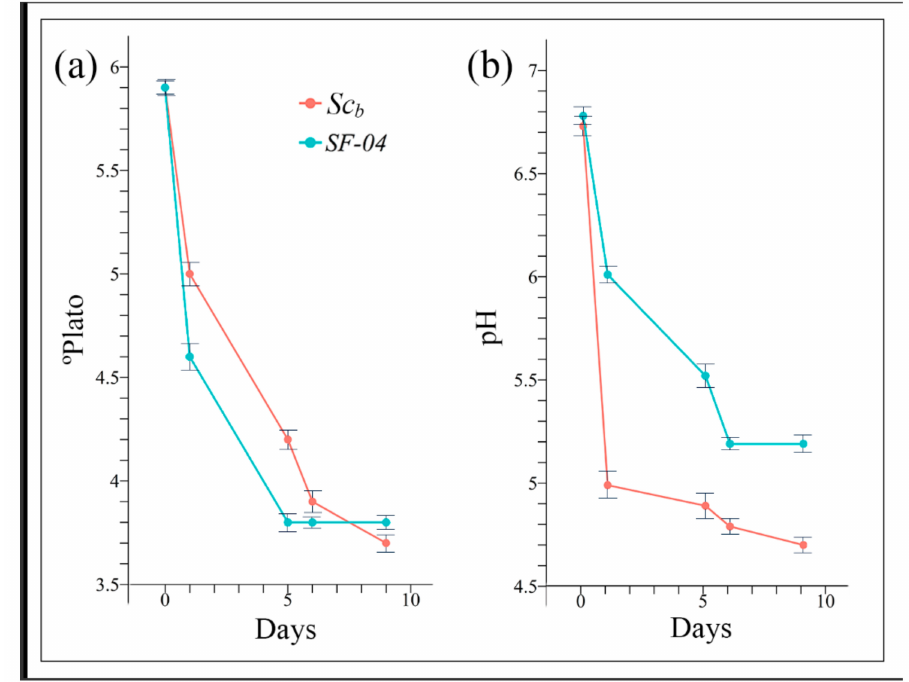
Figure 1. Plato degrees ( a ) and pH ( b ) evolution during beer fermentation using the Saccharomyces cerevisiae var. boulardii ( Sc b ) and Saccharomyces cerevisiae (SF-04) strains as single starters. Results shown as mean ± standard